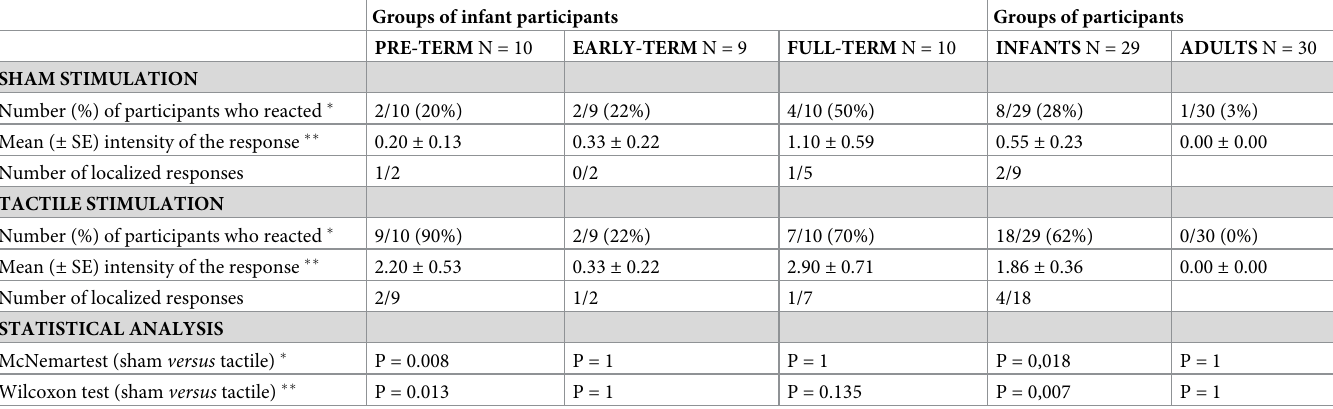
Table 2. Responses of infants (pre-term, early-term and full-term) and adults to both types (tactile versus sham) of stimulations.